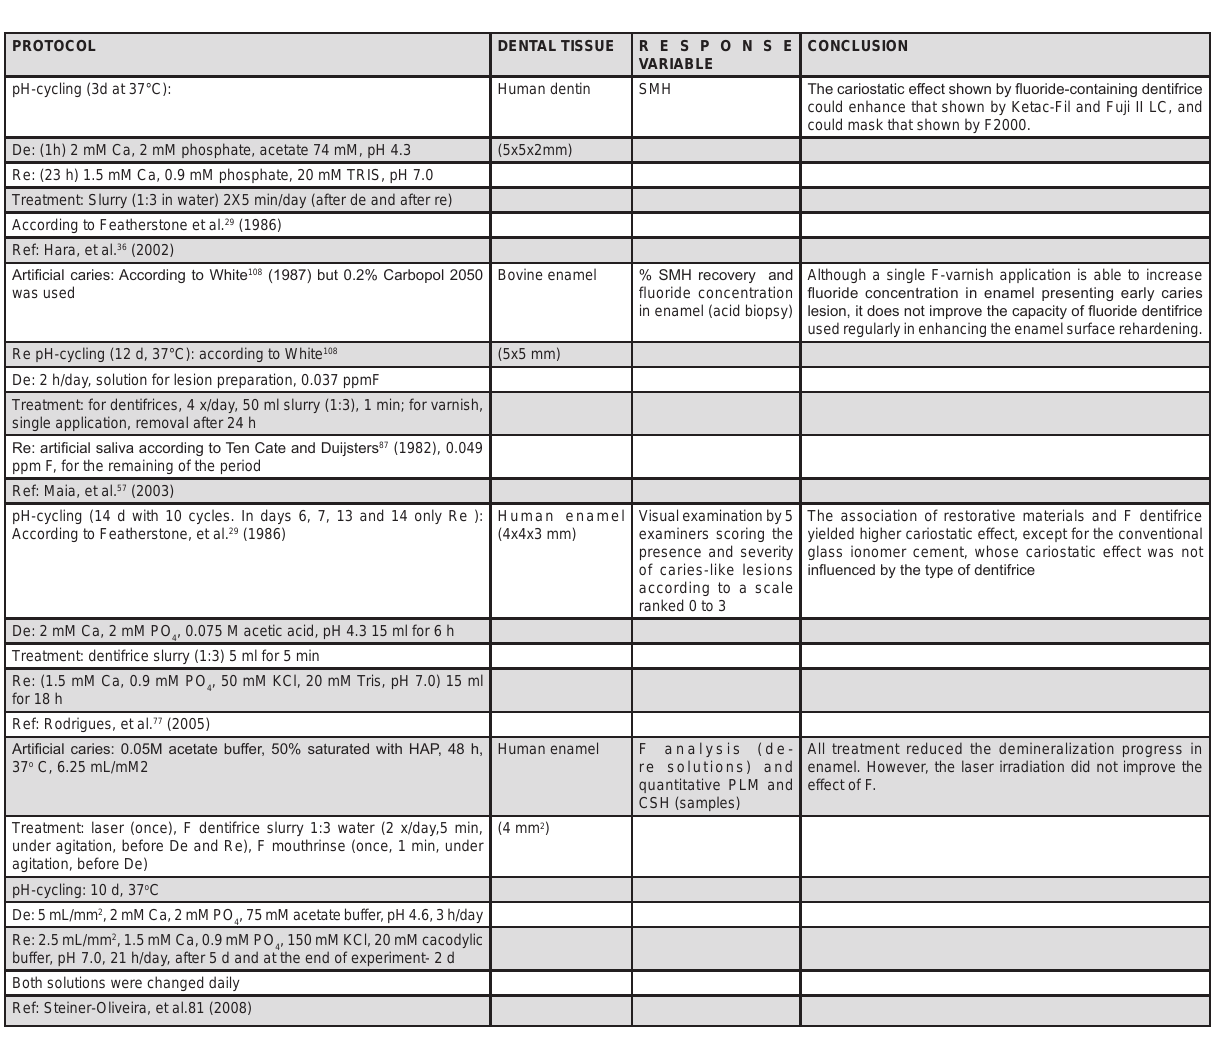
Figure 6- pH-cycling studies comparing the association between fluoride dentifrices and other treatments for caries prevention and